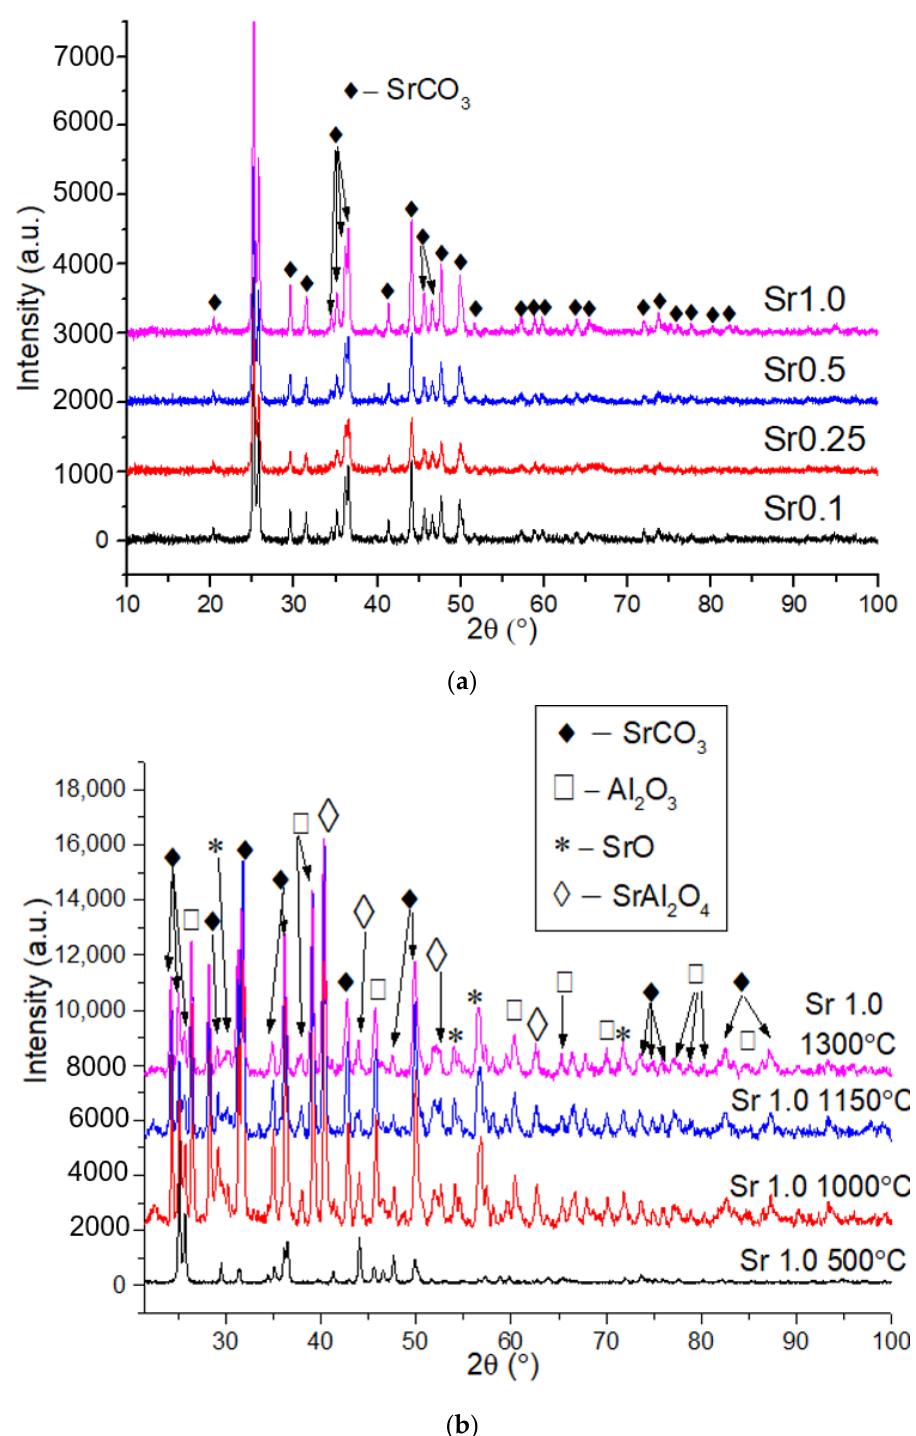
Figure 1. XRD patterns of Al 2 O 3 /SrCO 3 systems: ( a ) annealed at 500 °C (773 K) with Sr molar ratios of 0.1, 0.25, 0.5 and 1.0; ( b ) Sr 1.0 molar ratio at different temperature.